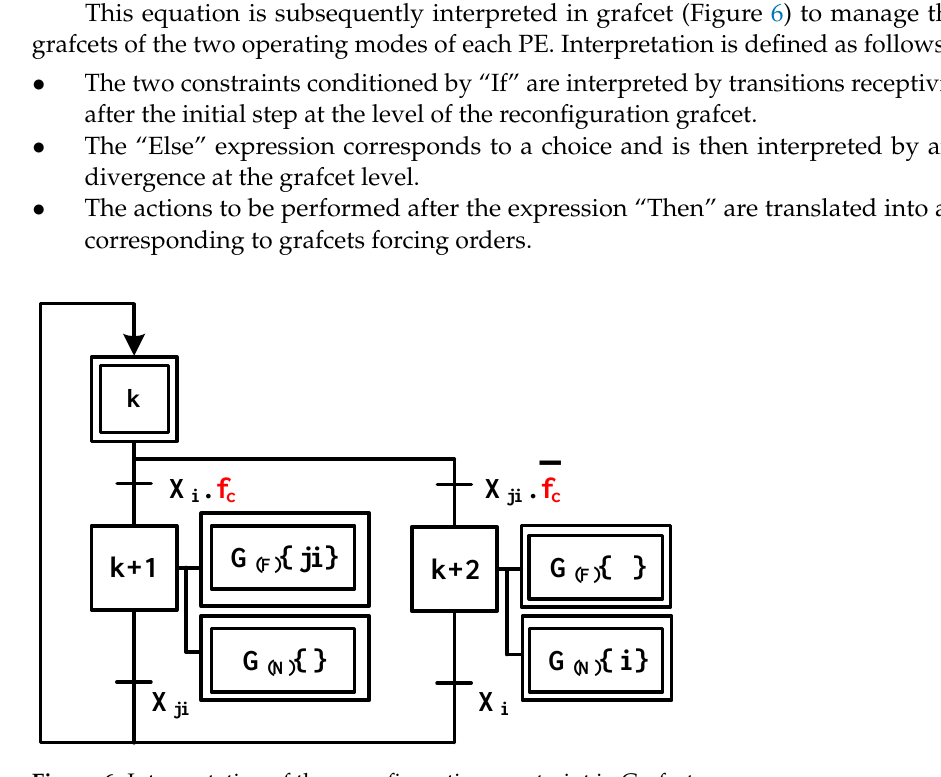
Figure 6. Interpretation of the reconfiguration constraint in Grafcet.